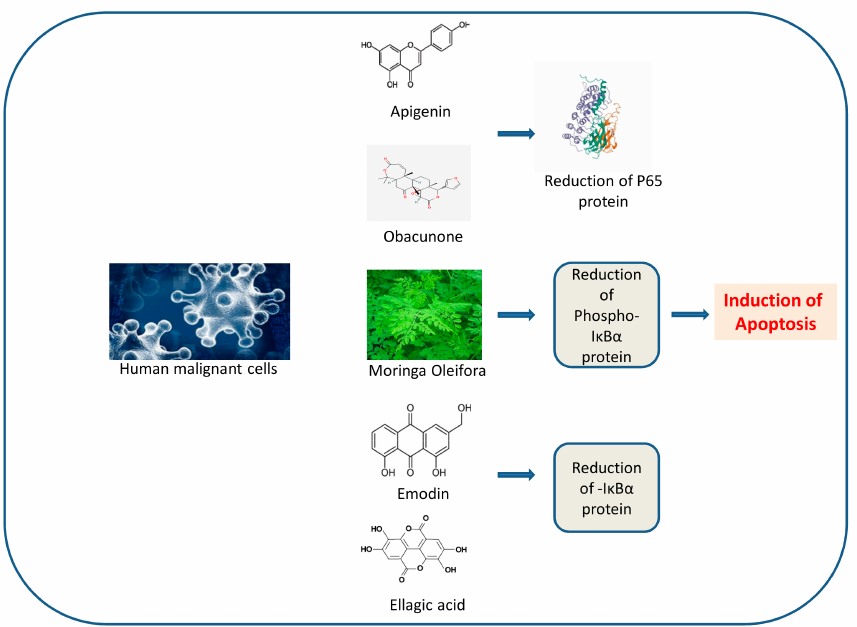
Figure 8. Inhibition of the NF- κ B signaling pathway by a number of chemical substances found on herbal and plant extracts. These substances reduce the levels of the expression of a number of key NF- κ B family proteins in the cells, including p65, phosphor-I κ B α , and I κ B α proteins, therefore inducing apoptosis and cell